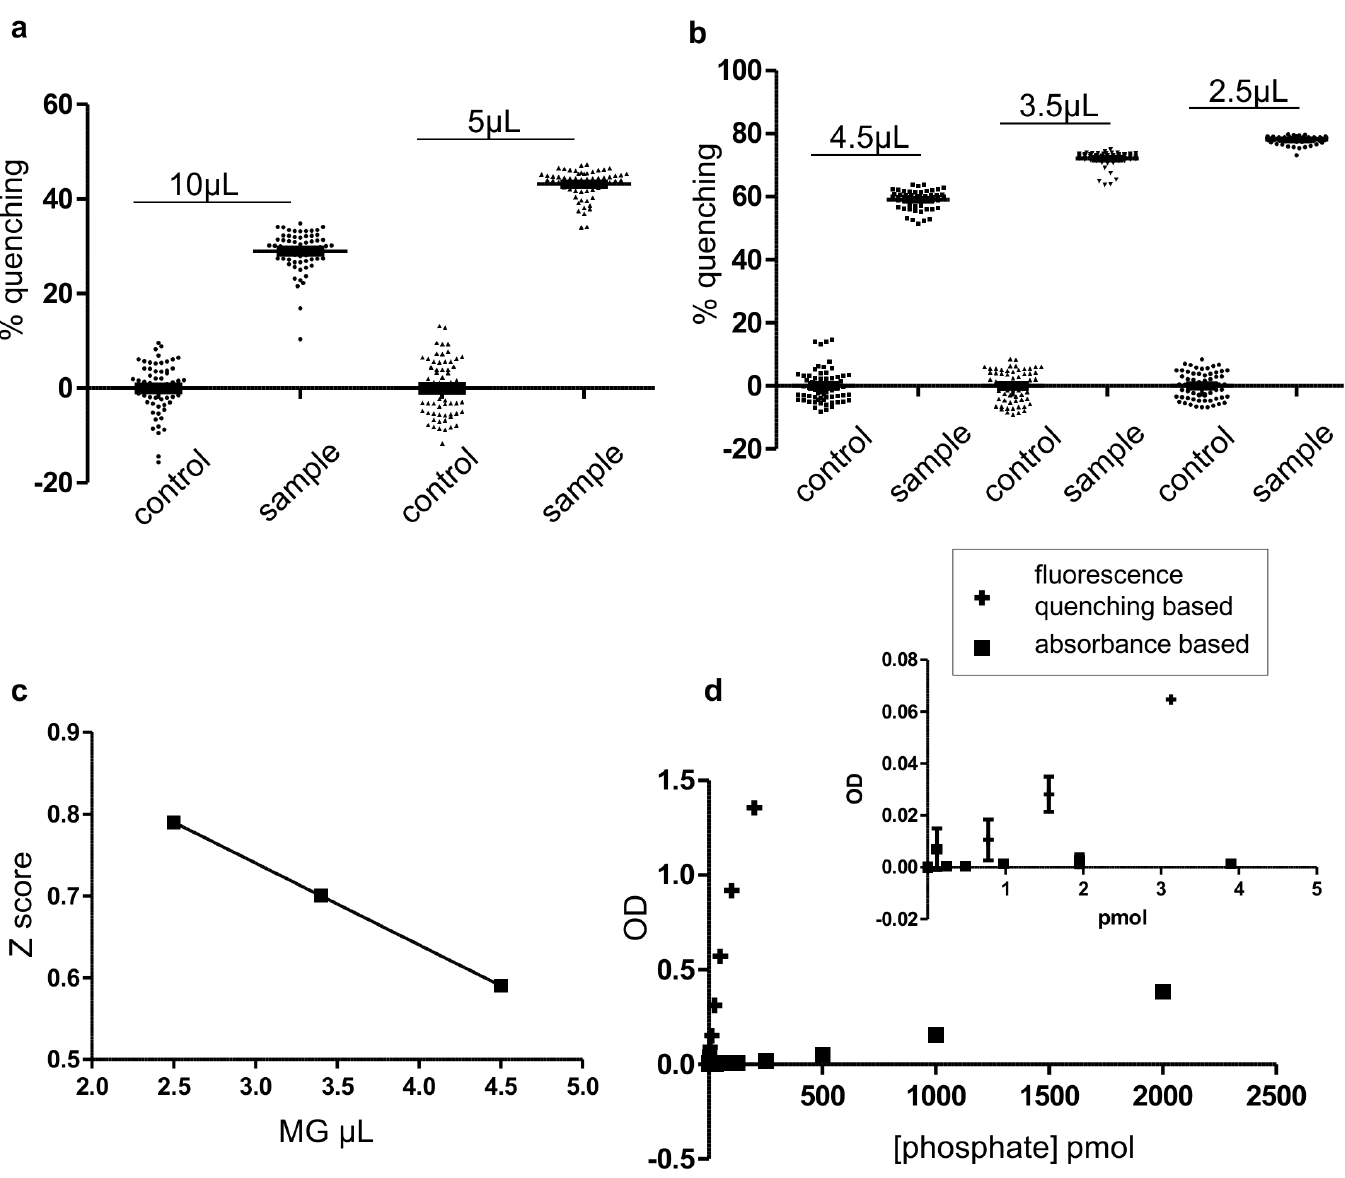
Fig 2. Miniaturization of the assay using phosphate standard. (a) The effect of different volumes of standard phosphate solution was studied by adding it into 384 Perkin Elmer white proxy plates. The malachite green volume was kept at ratio of 1.25:1 (reaction volume: developing reagent volume). (b) The influence of the malachite green quantity was measured using 200pmol phosphate in 5 μ L volume. (c) Z score was plotted against malachite green volume. Z score linearly decreases with malachite green volume. (d) A phosphate standard curve was generated using white plate fluorescence quenching versus absorbance assay in 96 well plates. Inset shows high sensitivity phosphate detection at lower concentrations. Our data indicate that the 5 μ L assay volume with 2.5 μ L developing reagent produces the optimum result using white proxy plates. In panels a and b, raw data was converted to OD and then % of quenching was